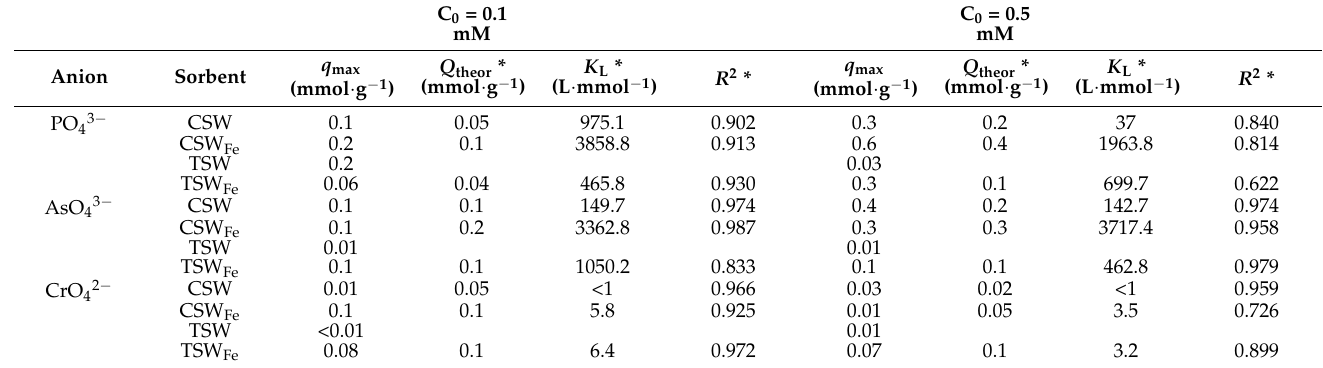
Table 3. Adsorption parameters for PO 4 3− , AsO 4 3− and CrO 4 2− adsorption on CSW/CSW Fe and TSW/TSW Fe .